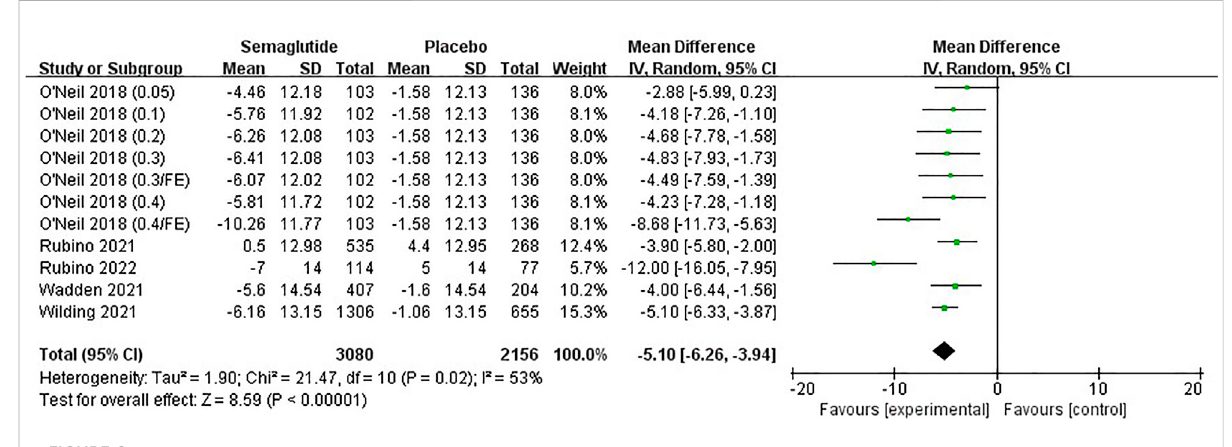
FIGURE 8 Meta-analysis results of SBP change (mm Hg) in included trials.